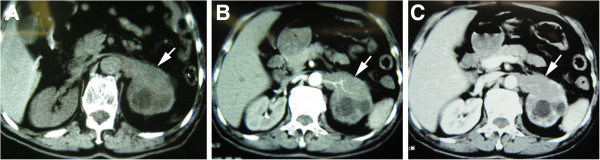
CT showing left renal tumor. Plain CT scan revealed a heterogeneous density in the left renal tumor (A, arrow). The borders between the tumor and abdominal aorta, kidney and renal vein were not clear. Enhanced CT scan suggested a slight enhancement in the arterial phase (B, arrow) and a moderate enhancement in the venous stage (C, arrow).